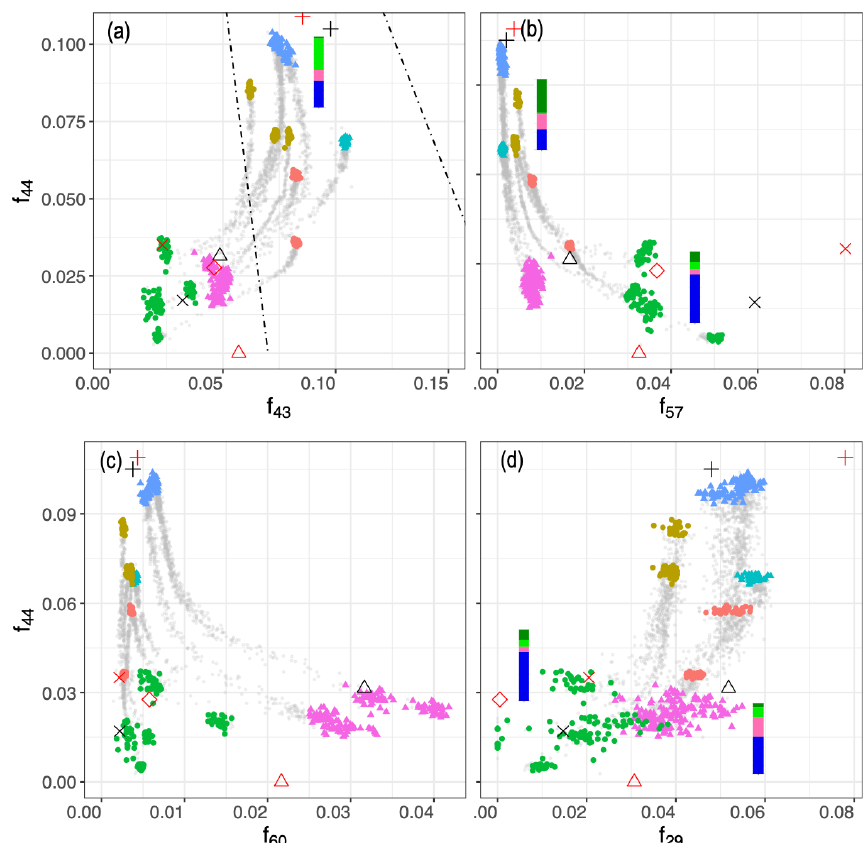
Figure 5. Scatter plots of f 44 ( f ) against f 43 ( f C + ), f 57 ( f C + ), f 60 ( f C + ), and f 29 ( f CHO + ). Dashed lines show the CO 2 + 2 H 3 O 4 H 9 2 H 4 O 2 outline of the triangle (Ng et al., 2010), and the black shapes show the location of PMF factors (Elser et al., 2016; Aiken et al., 2009; Ulbrich et al., 2009). Average FG composition for each category estimated from the MIR spectra are shown beside the category. Figure 4 legend is applicable